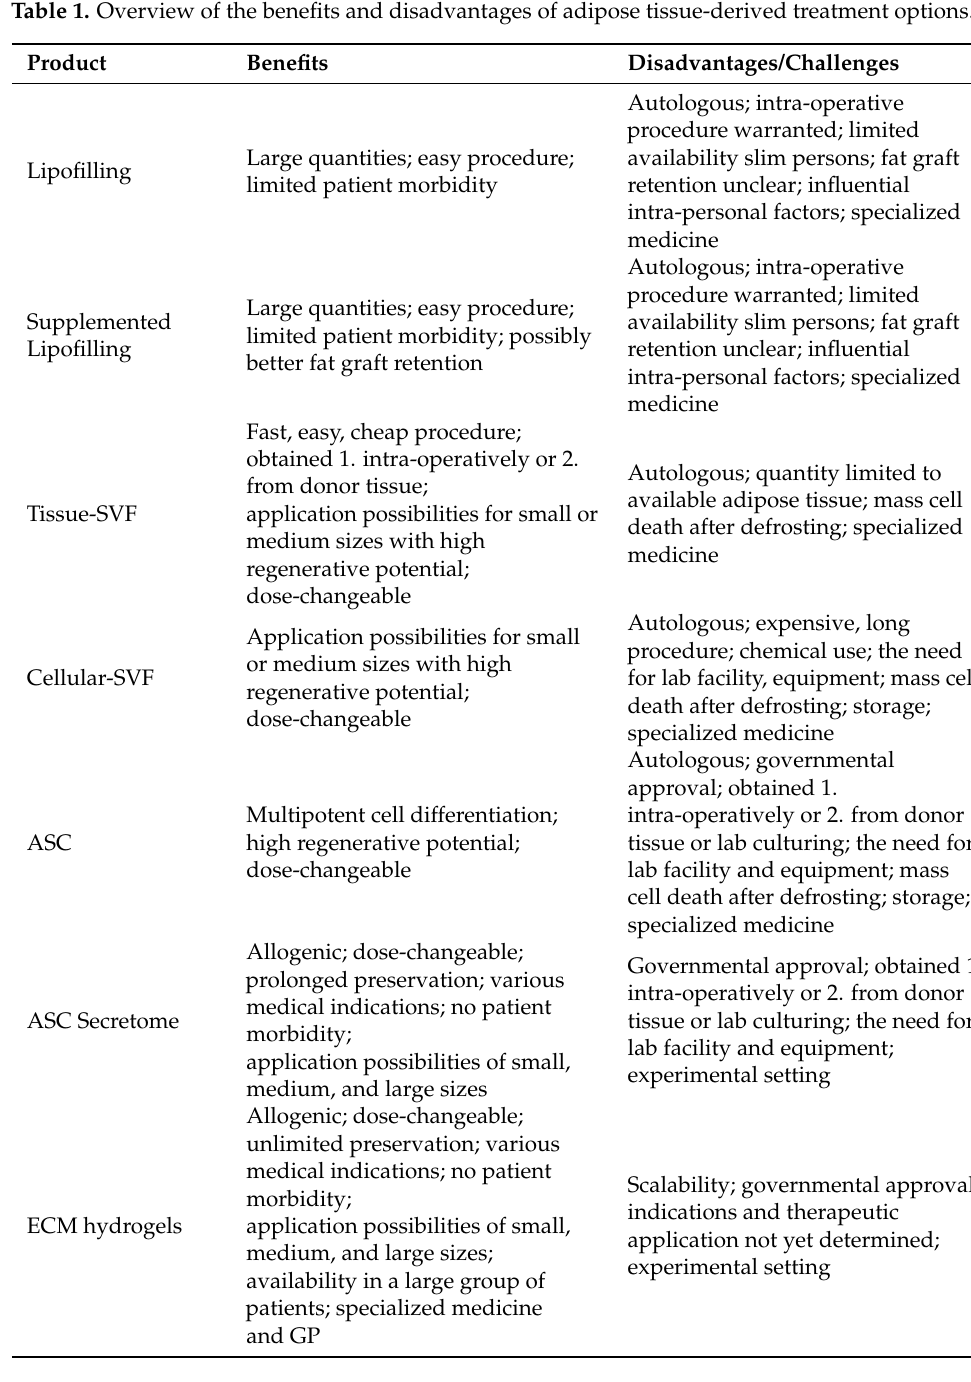
Table 1. Overview of the benefits and disadvantages of adipose tissue-derived treatment